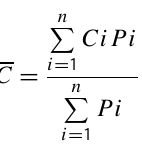
Fig. 4. Emission contributions by subcategories of livestock for the year of 2006.